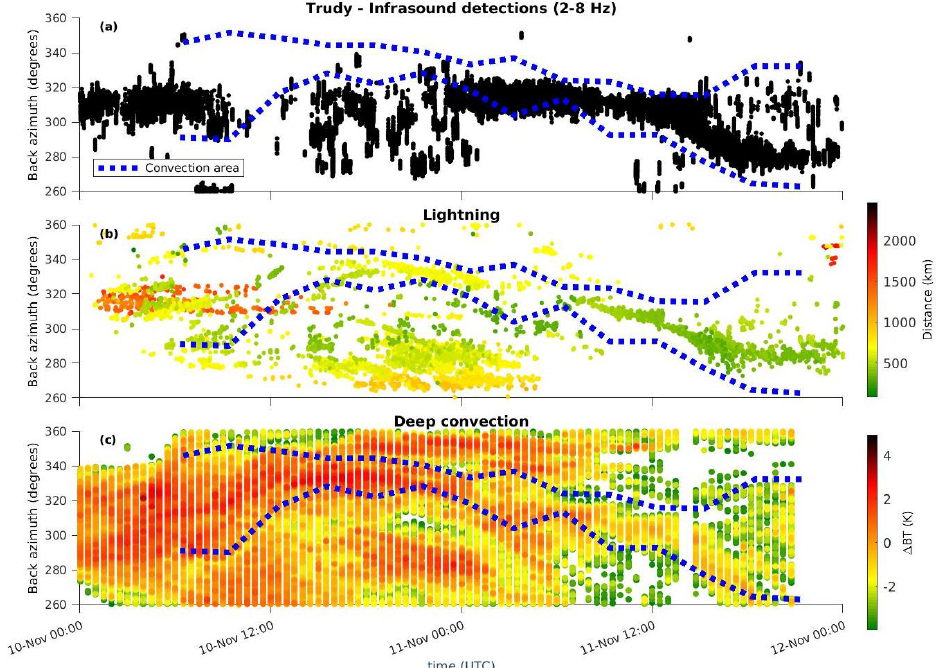
Figure 13. Time series related to Trudy. ( a ) PMCC detections in the 2–8 Hz band, as shown in Figure 3a. The dashed blue line indicates the edges of the main convective system related to the medicane (see text for details). ( b ) Deep convection (DC) pixels color-coded by the difference in brightness temperature (BT) introduced in Section 2.3. Positive values of ΔBT indicate deep convection, and larger values relate to stronger deep convection ( c ) WWLLN detections of lightning related to Trudy color-coded by the distance of the lightning to IS48.